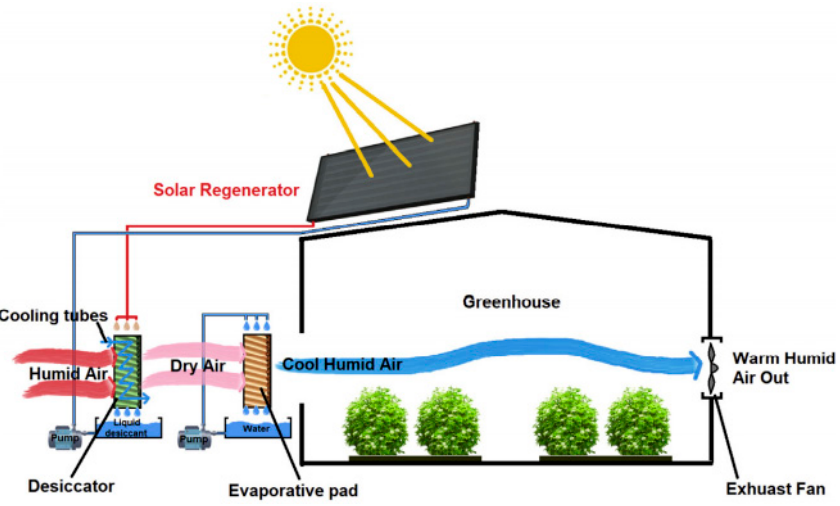
Figure 8. Schematic of solar-assisted desiccant cooling system. Reprinted with permission from Ref. [97]. Copyright 2019